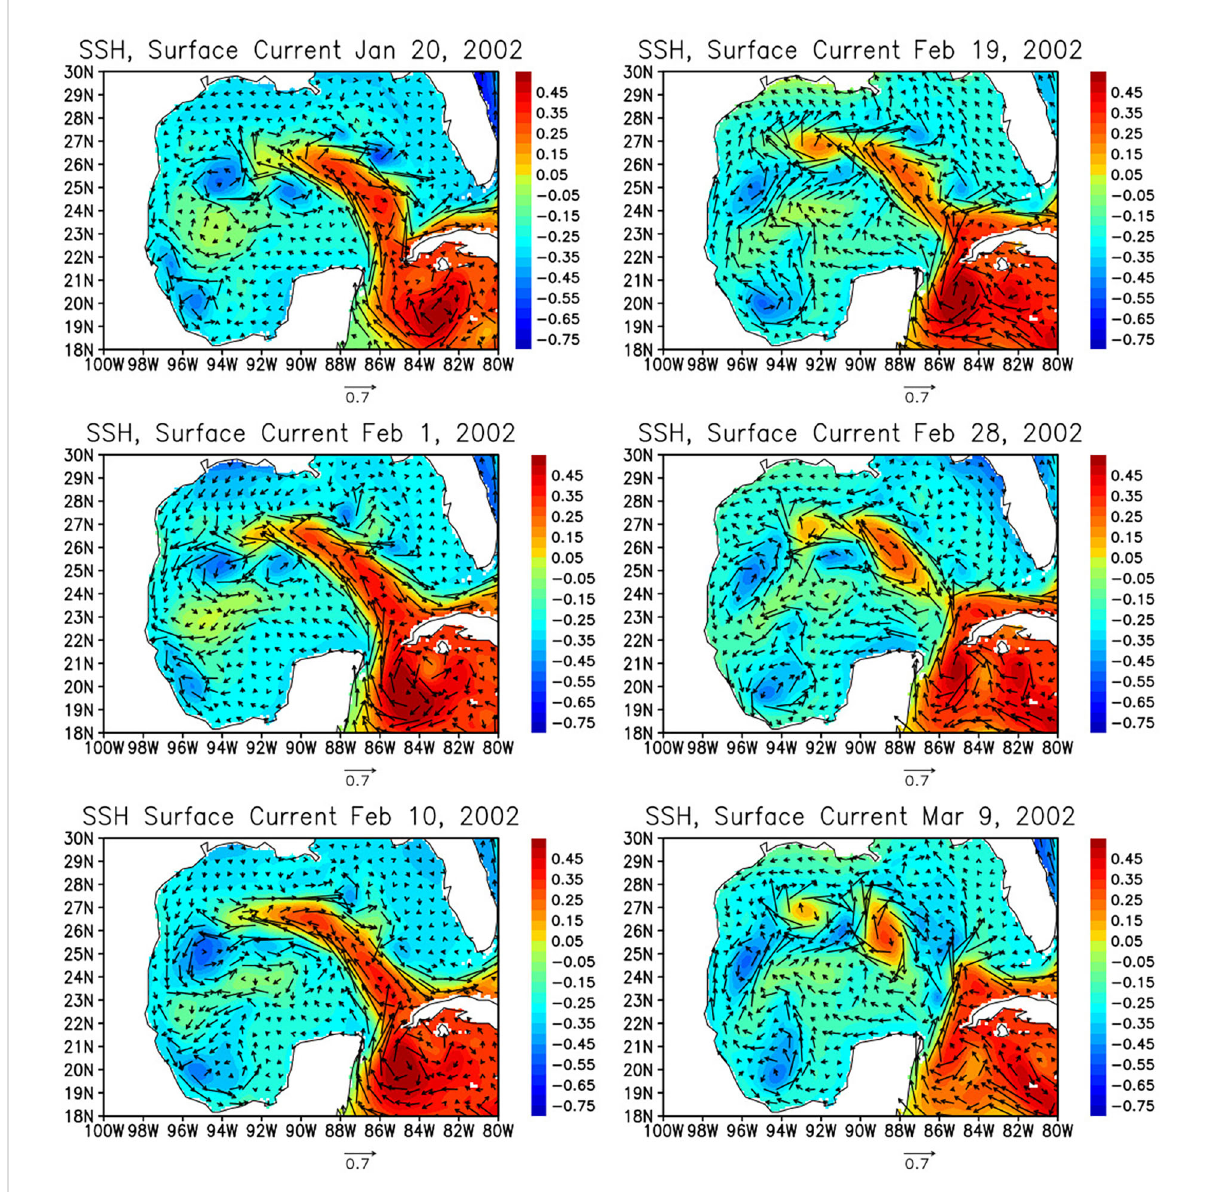
FIGURE 7 Surface currents (arrows) and SSH (shading) in January 20, February 1, 10, 19, 28, and March 9, 2002 derived from the HYCOM